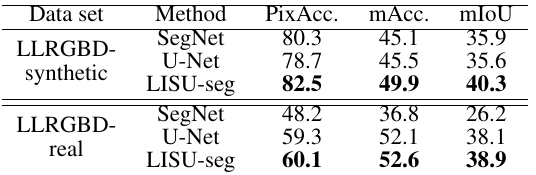
Table 2. Comparison of segmentation accuracy of degraded reflectance